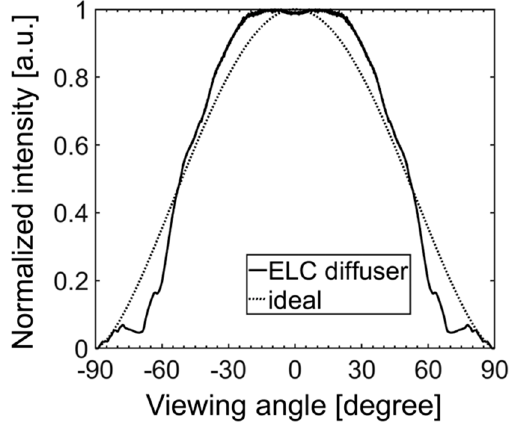
Figure 6. Normalized intensities of ELC diffuser and the ideal diffuser according to viewing angle.